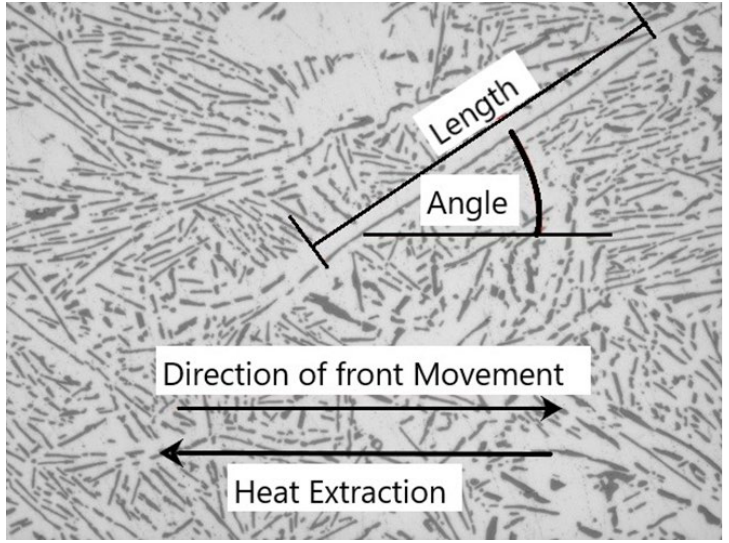
Figure 2. Different measured parameters in the Al–Si eutectic alloy (M = 500×).